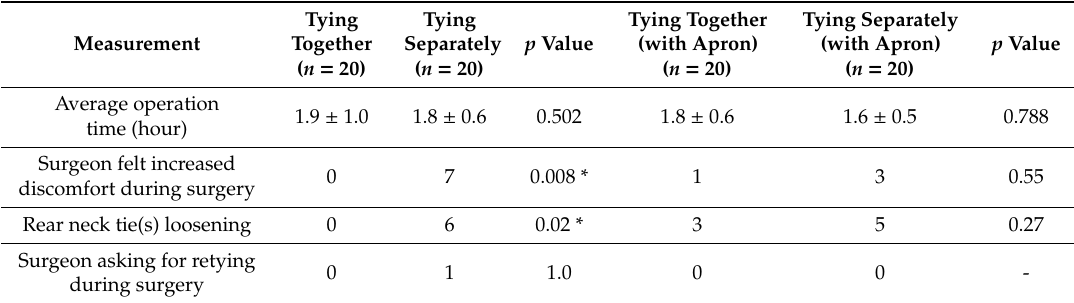
Table 2. Surgeons’ responses to di ff erent tying